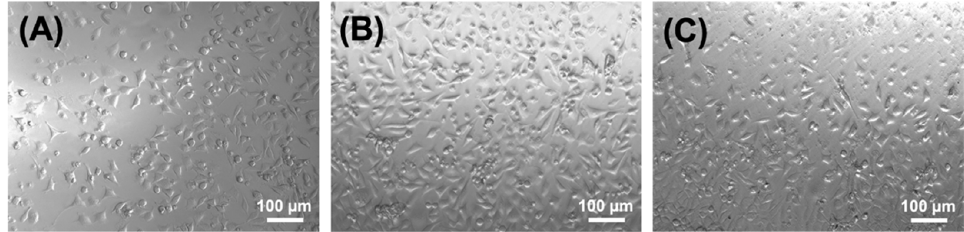
Figure 7. Optical microscopy images of L929 murine fibroblasts following 48-h culture on extracts of wet spun samples F-4VBC* ( A ), F-4VBC-MA* ( B ) and F-GMA* ( C ).